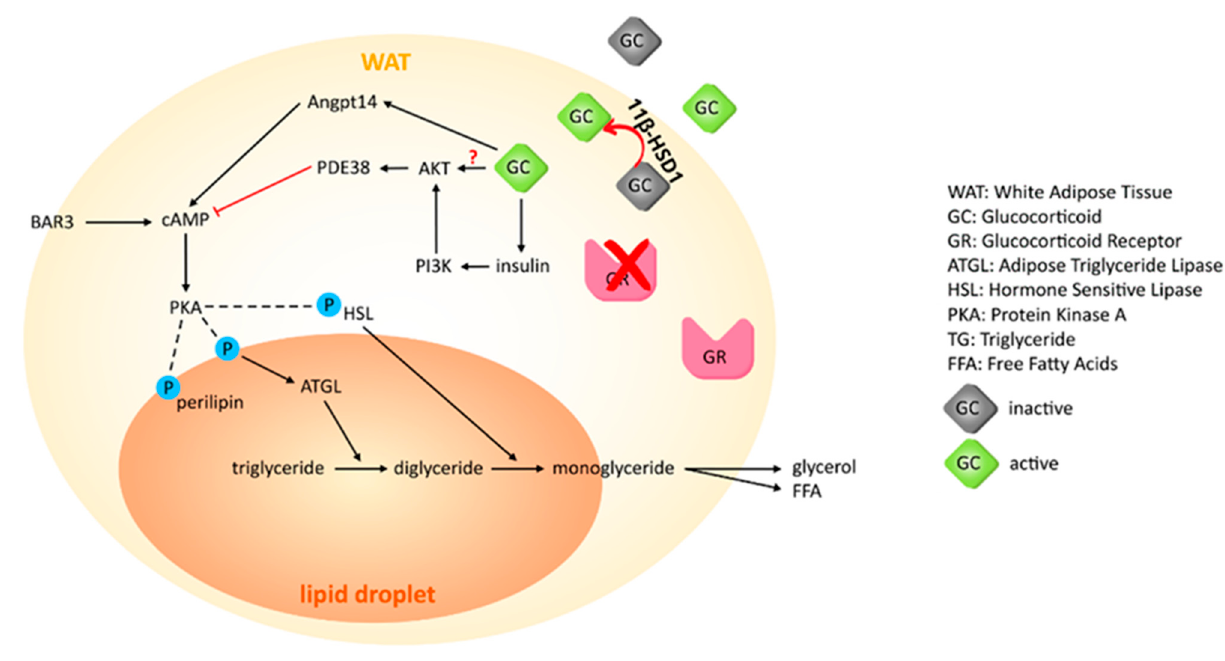
Figure 3. Non-genomic effects of GCs on lipolysis in WAT. The non-genomic effects are independent of ATGL/HSL gene or protein expression. Multiple suggested non-genomic mechanisms include AKT-PDE3B pathway, the ANGPTL4-cAMP pathway, and the insulin-PI3K pathway. The ANGPTL4 is a GR target gene that may be classified as inducing possible non-genomic mechanisms through its activation in cAMP. The non-genomic pathways affect lipolysis by regulating activity of HSL/perilipin through affecting phosphorylation. 11 β -HSD1: 11- β hydroxysteroid dehydrogenase type, AKT: Protein Kinase B, PDE3B: phosphodiesterase 3B, ANGPTL4: Angiopoietin-like protein 4, cAMP: Cyclic adenosine monophosphate, PI3K: Phosphatidylinositol 3-kinase, BA3R: Beta-3 adrenergic receptor.